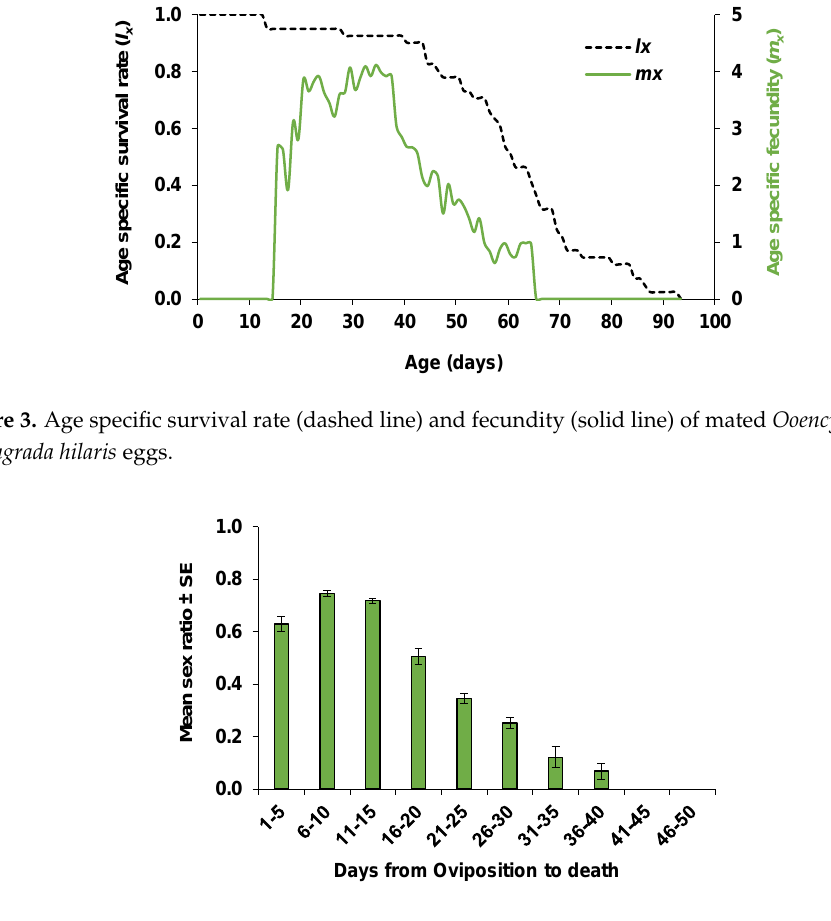
Figure 4. Mean ( ± SE) sex ratio (females/progeny/day) of mated females (n = 22) of Ooencyrtus lucidus on Bagrada hilaris eggs at five-day intervals from oviposition to death. Table 2. Population growth parameters (mean ± SE) of Ooencyrtus lucidus on Bagrada hilaris